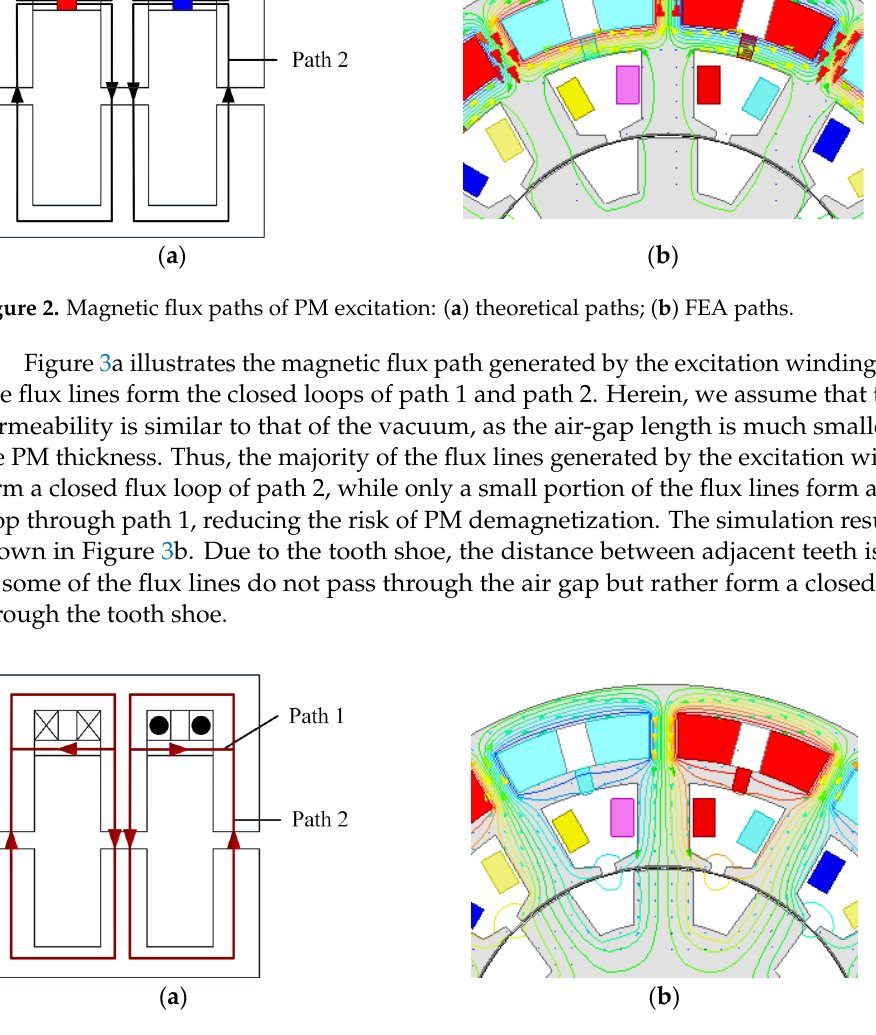
( b ) Figure 4. Magnetic flux paths of hybrid excitation when J f < J f 0 : ( a ) theoretical paths; ( b ) FEA paths. ( a ) ( b ) Figure 5. Magnetic flux paths of hybrid excitation when J f > J f 0 : ( a ) theoretical paths; ( b ) FEA paths.